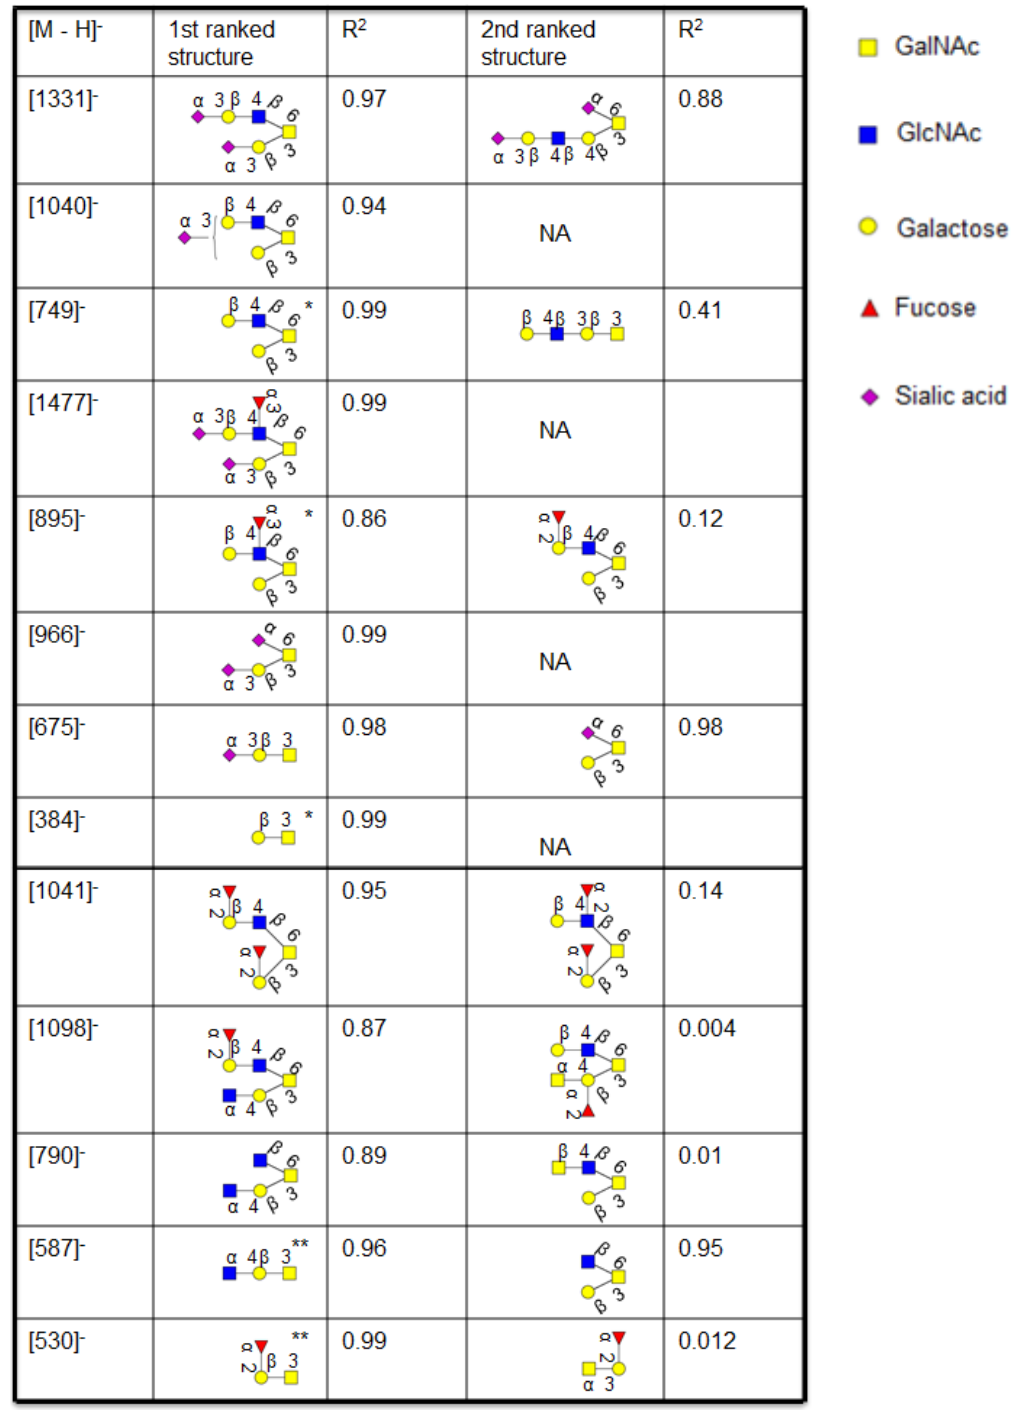
Table 1. The MS 2 spectral intensity correlation comparison of the sialylated and neutral structures with spectra reported in the MS 2 database UniCarb-DB. The sialylated structures did not give a good match due to loss of labile sialic acid leaving behind very little information. The R 2 value is a measure of how well all peaks and their intensities in an MS 2 spectrum are matching with the database peak list. Symbols used are according to the Consortium for Functional Glycomics guidelines [20] and was generated by Glycoworkbench [21].*indicates structures that are created after de-sialylation.** indicates structures created after loss of terminal